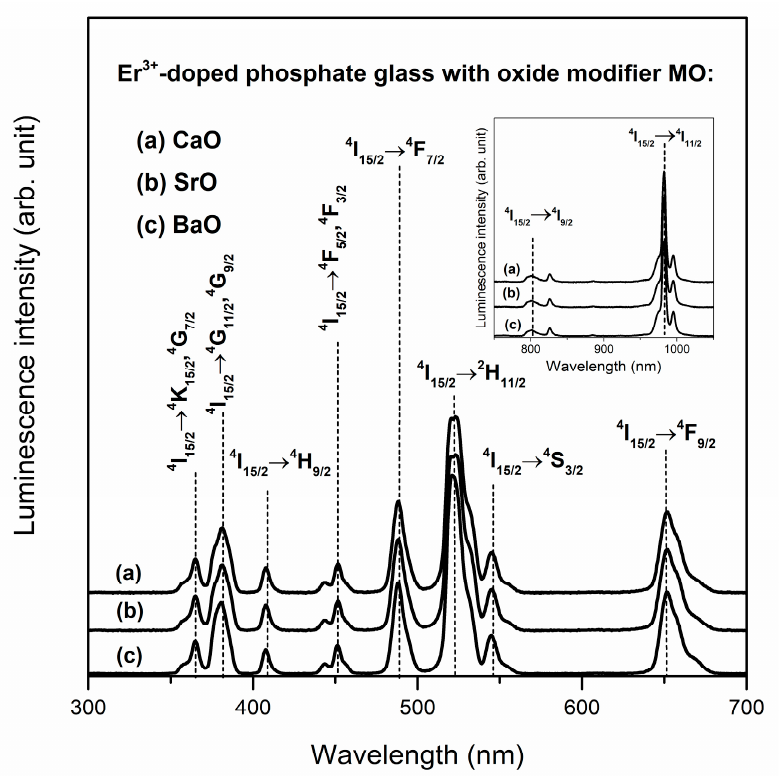
Figure 10. Excitation spectra for Er 3 + -doped phosphate glasses with oxide glass modifiers MO.